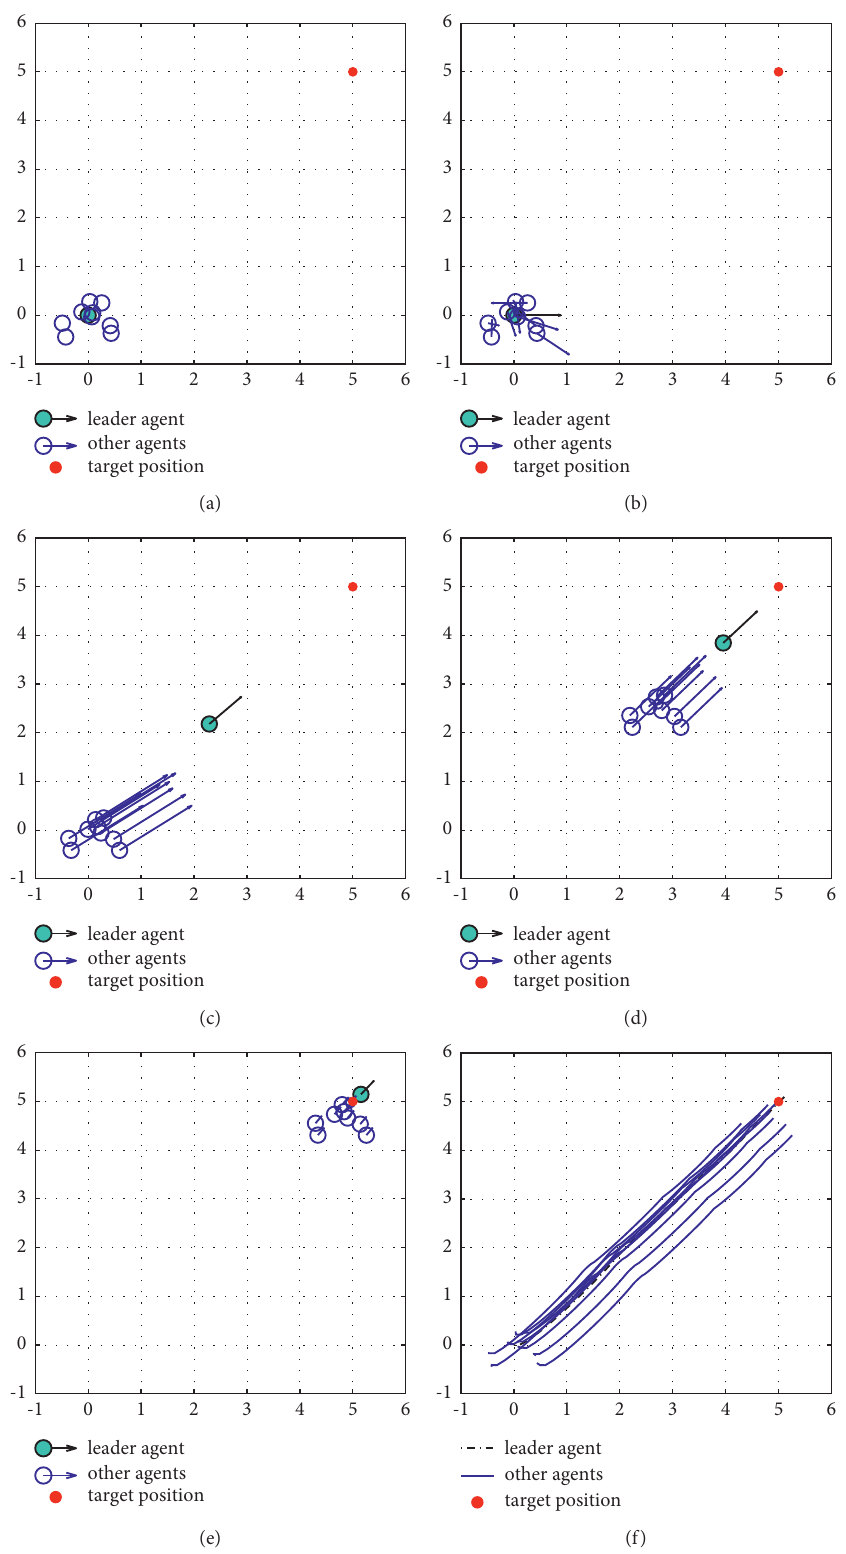
Figure 4: The movement of agents reaching final target position governed by leadership of CS model with time delay τ � 2 for t ∈ [ 0 , 10 ] . (a) Initial configuration. (b) t � 1. (c) t � 2. (d) t � 5. (e) t � 10. (f) t ∈ [ 0 , 10 ]